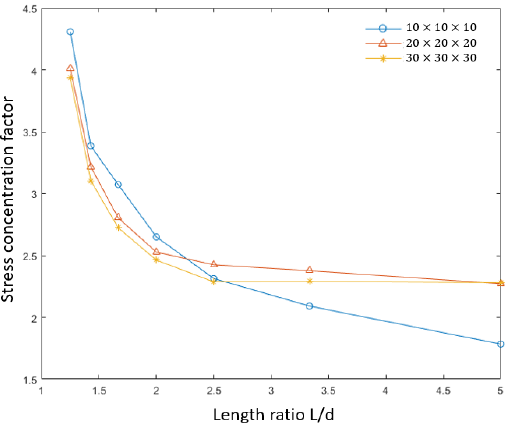
Figure 22. Von Mises stress and stress concentration behavior around the equator of the spherical inclusion. The sphere has a diameter of 0.2 and is placed at the center of a 1 × 1 × 1 cubic domain.